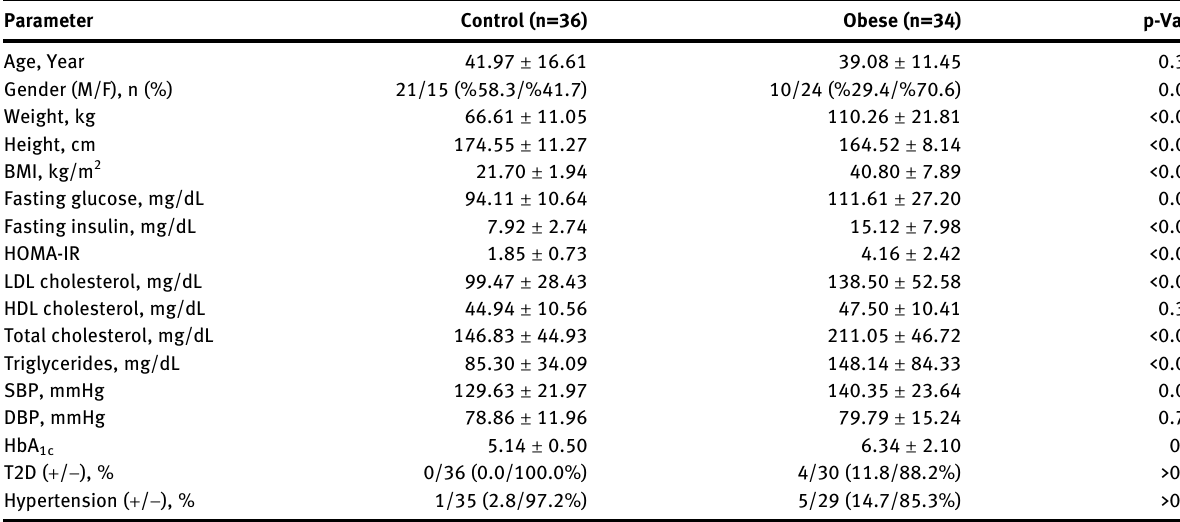
Table  : Anthropometric and biochemical parameters in obesity patients and controls. Parameter